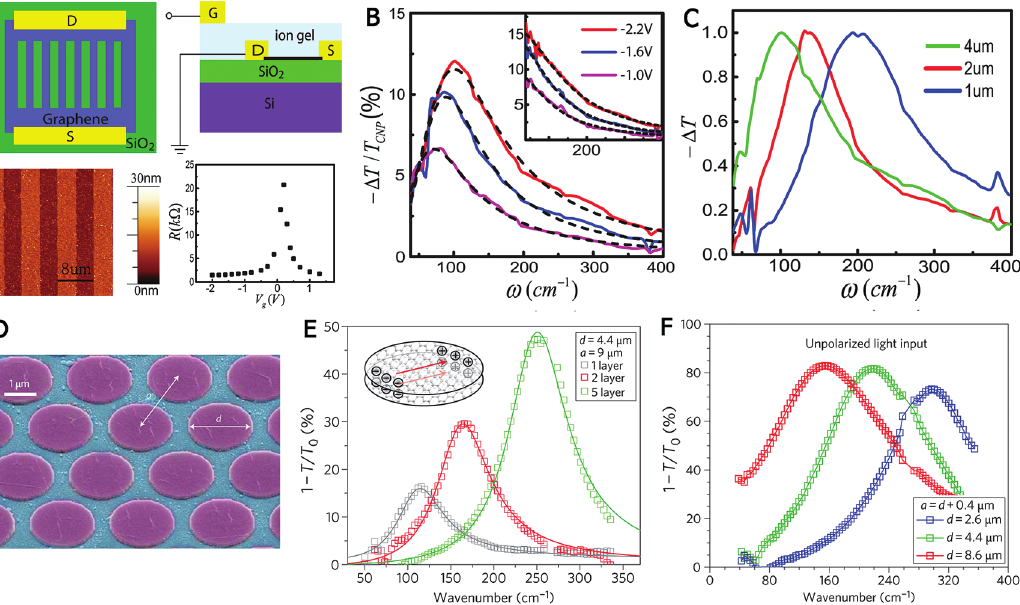
Figure 8 (A) Graphene micro-ribbon array. Four panels in the clockwise direction show the top-view, side-view, gate-dependent electrical resistance trace, and the AFM image of a sample with the grapheme ribbon width of 4 μ m and the period of 8 μ m. (B) Control of the absorp- tion of graphene plasmons via electrical gating. The graphene ribbon array is the same as in (A), and the polarization is perpendicular to the graphene ribbon. For comparison, the inset shows the corresponding spectra for terahertz radiation polarized parallel to ribbons. In this case, the absorption strength increases with carrier concentration (bias voltage), but the spectral shape remains the same. (C) Spectra of change of transmission with different microribbon widths (1, 2, and 4 μ m). (D) SEM image and (E) extinction spectra of patterned graphene/ insulator stacks with varied numbers of graphene layers. (F) Tunable terahertz filters using stacked graphene devices with different diam- eters of the stack. The total number of graphene layers is fixed at five. (A–C) are adopted from Ref. [140], and (D–F) are adopted from Ref. [142] with